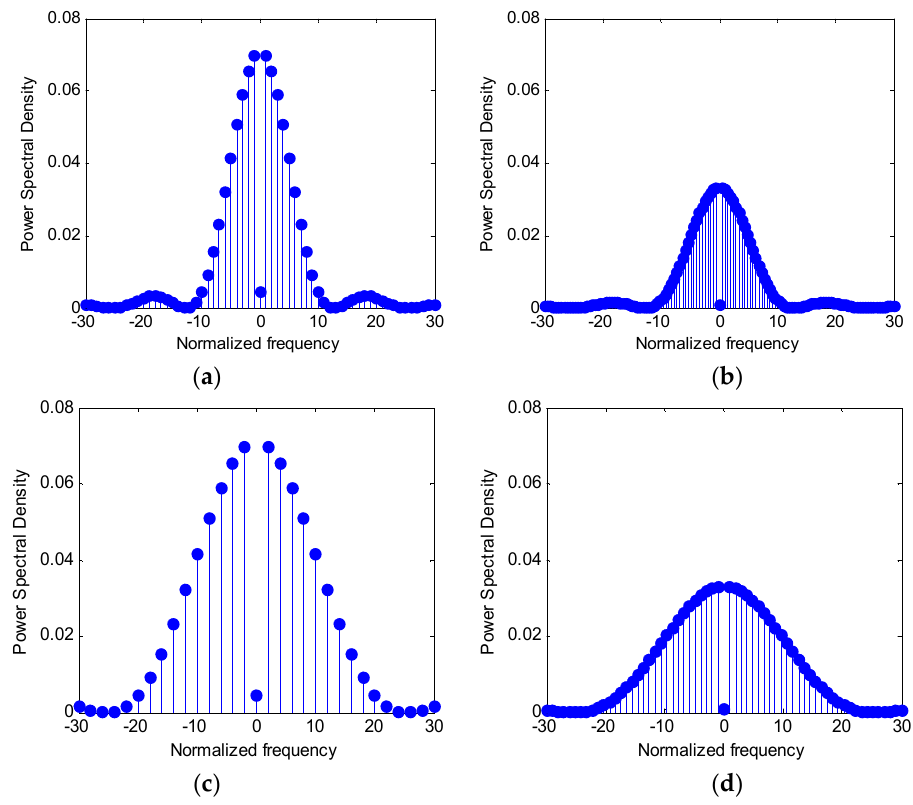
Figure 8. Power spectral density (PSD) of periodic m-sequences with different periods and symbol widths. ( a ) PSD of m-sequences with N 1 = 15 and ∆ t 1 ; ( b ) PSD of m-sequences with N 2 = 31 and ∆ t 1 ; ( c ) PSD of m-sequences with N 1 = 15 and ∆ t 1/2 ; ( d ) PSD of m-sequences with N 2 = 31 and ∆ t 1/2 . Table 2. Effect of m-sequence symbol width.